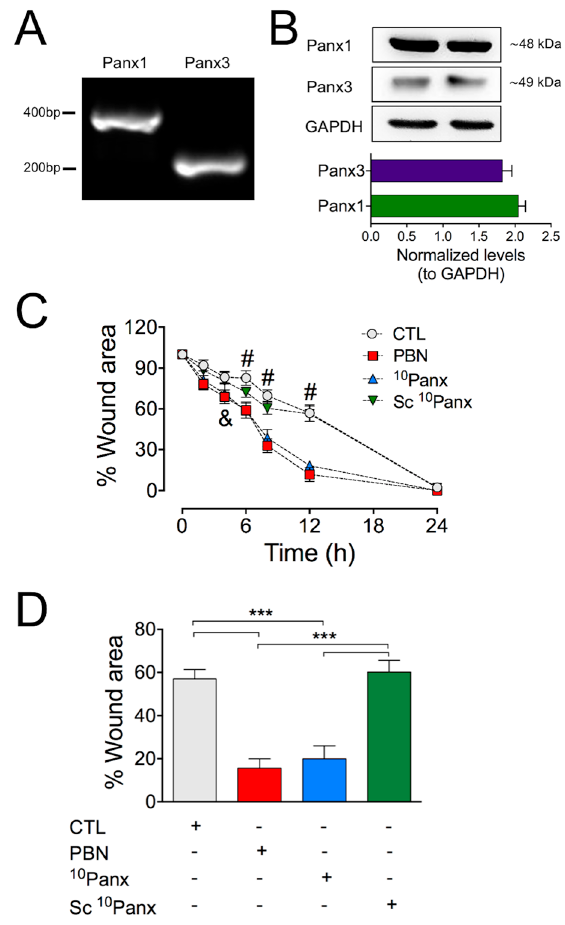
Figure 1. Inhibition of Panx1 channels accelerates wound closure in HDF cultures. ( A ) RT-PCR analysis of Panx1 and Panx3 mRNA in HDFs. ( B ) Representative Western blot showing protein levels of Panx1 and Panx3 in homogenates of HDFs. GAPDH immunodetection was used as a loading control. The graph shows the normalized levels of Panx1 and Panx3 in respect to GAPDH expression from 6 HDF cultures. ( C ) Time course of the wound healing process in HDF cultures. The scratch area was expressed as the percentage of wound area at each time relative to 0 h. CTL: control (untreated cultures). Panx1 channels were blocked using probenecid (PBN, 200 µM) and the mimetic peptide 10 Panx1 ( 10 Panx, 100 µM). The scrambled peptide was used as control (Sc 10 Panx, 100 µM). Statistical significance was found between controls and PBN or 10 Panx1. & = * p < 0.05 for 4 h; # = *** p < 0.001 for 6, 8, and 12 h; n = 10 (two-way ANOVA followed by Bonferroni’s post hoc test). ( D ) Comparison between wound healing rates 12 h after scratching for each treatment. *** p < 0.001; n = 10 (two-way ANOVA followed by Tukey’s post hoc test). All data are shown as mean ± SEM, n = 10 experimental replicas from at least four different cultures. Supplementary Figure S1A shows representative images of these experiments.